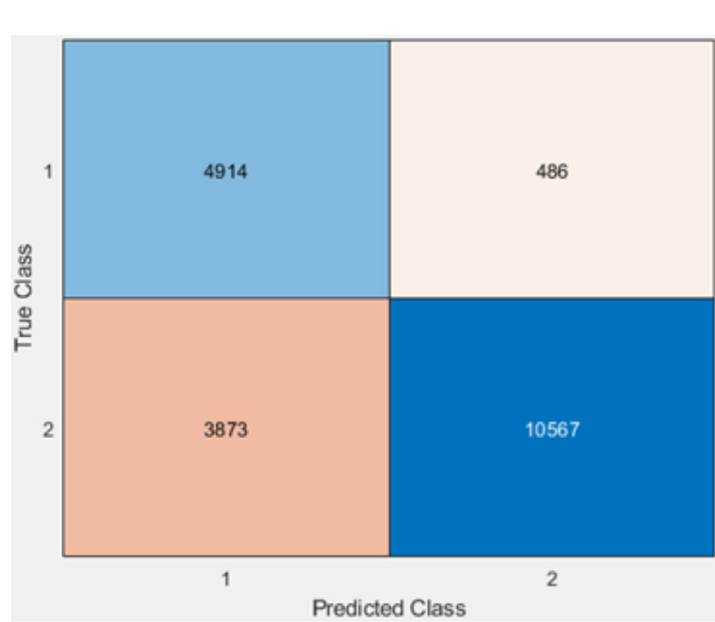
Fig. 10 The SVM’s Confusion Matrix for Voice Replay